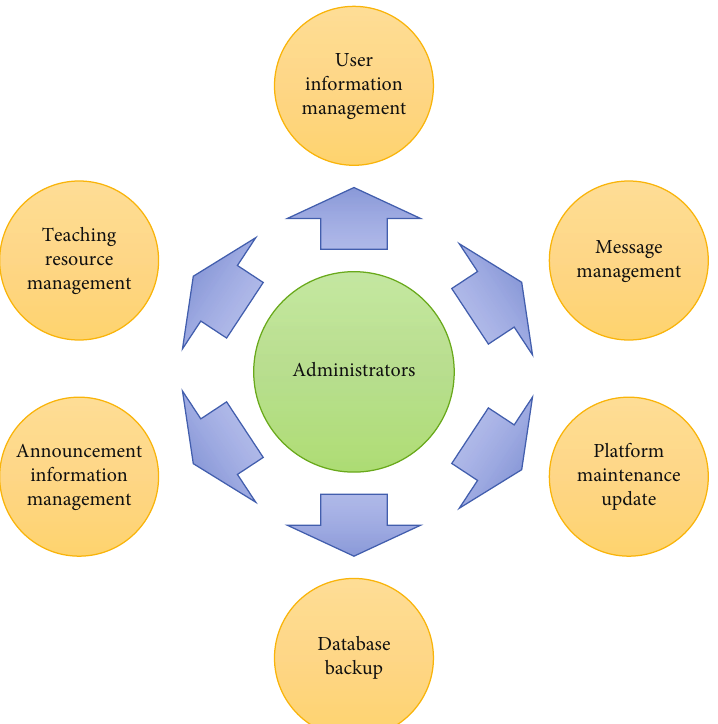
Figure 8: Administrator function